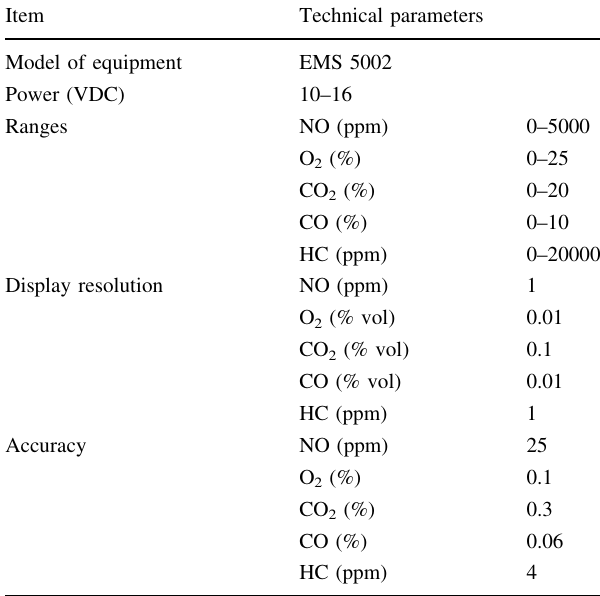
Table 2 Accuracies of the measuring instruments and the gas analyzers